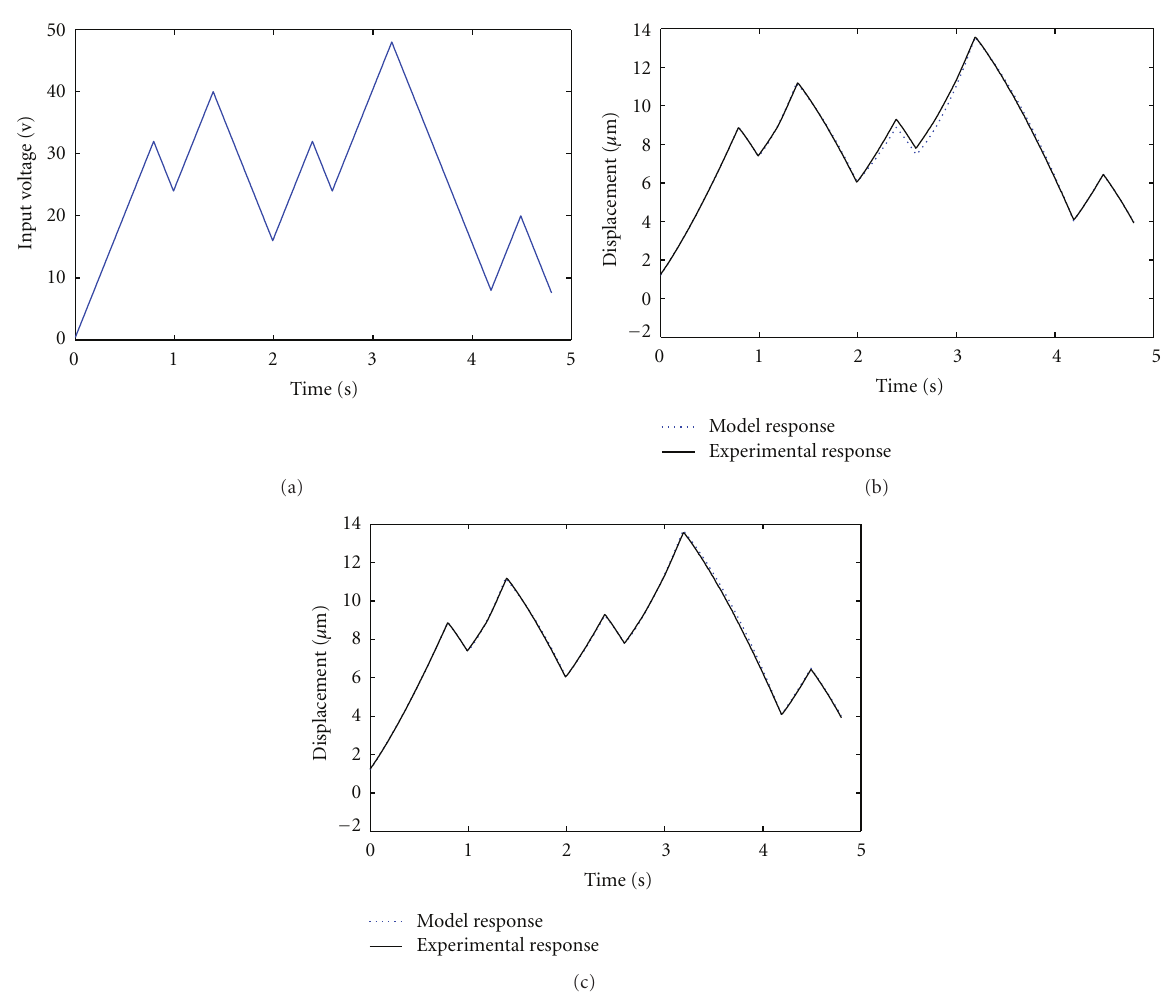
Figure 5: (a) The experimental input signal. (b) The experimental response and the proposed model response, and (c) the experimental response and the saturated memory model